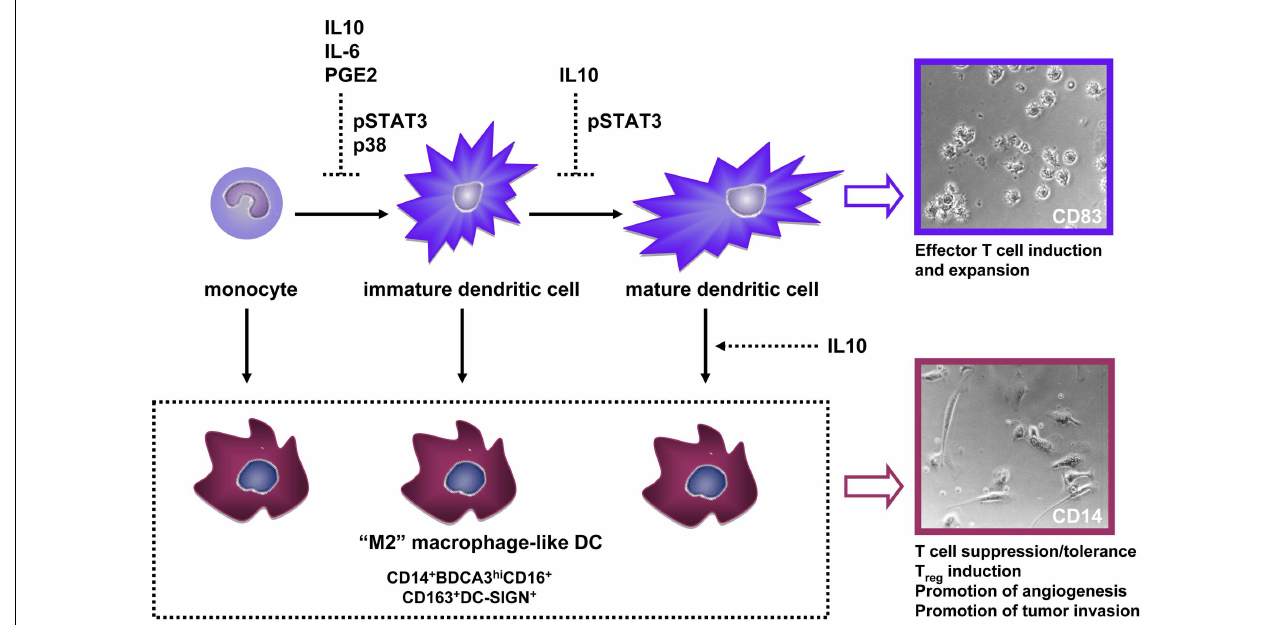
FIGURE 2 | Interference by tumor-associated soluble factors with normal dendritic cell (DC) development through indicated underlying signaling pathways, leads to (trans-)differentiation of CD14 + M2-macrophage-like cells with immune-suppressive and tumor growth- and